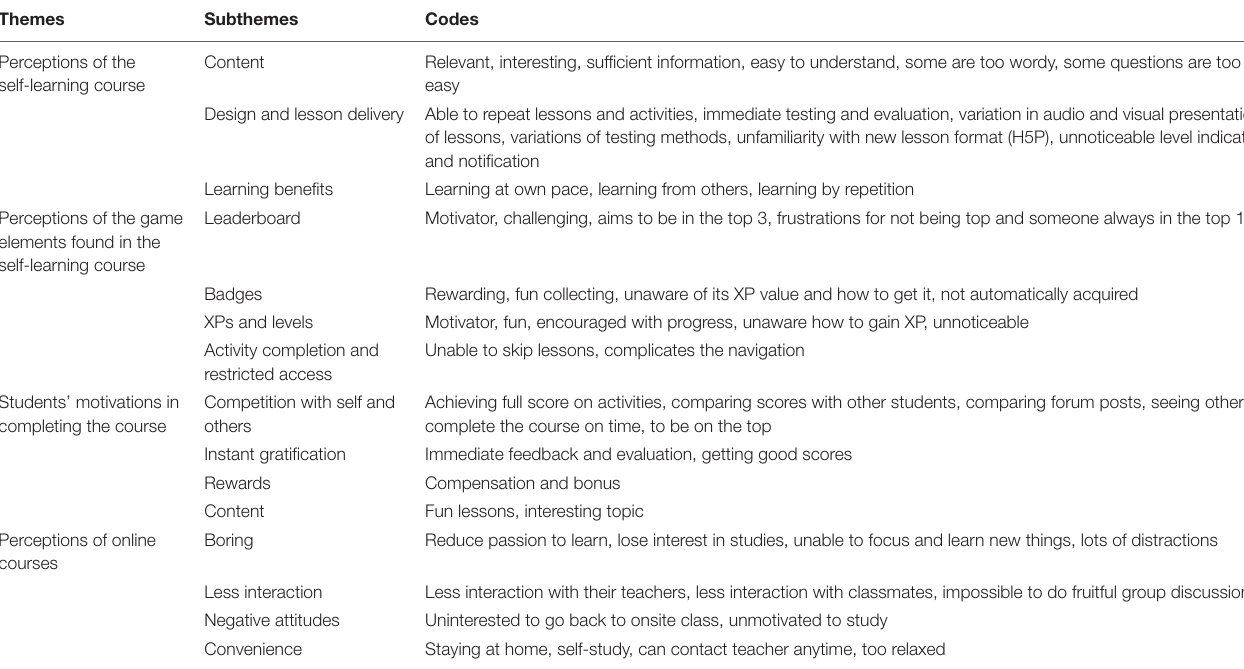
TABLE 1 | Excerpt of the summarized coding based on the empirical data analysis (the list is not exhaustive, but representative of the data analysis process). Themes Subthemes Codes Perceptions of the self-learning course